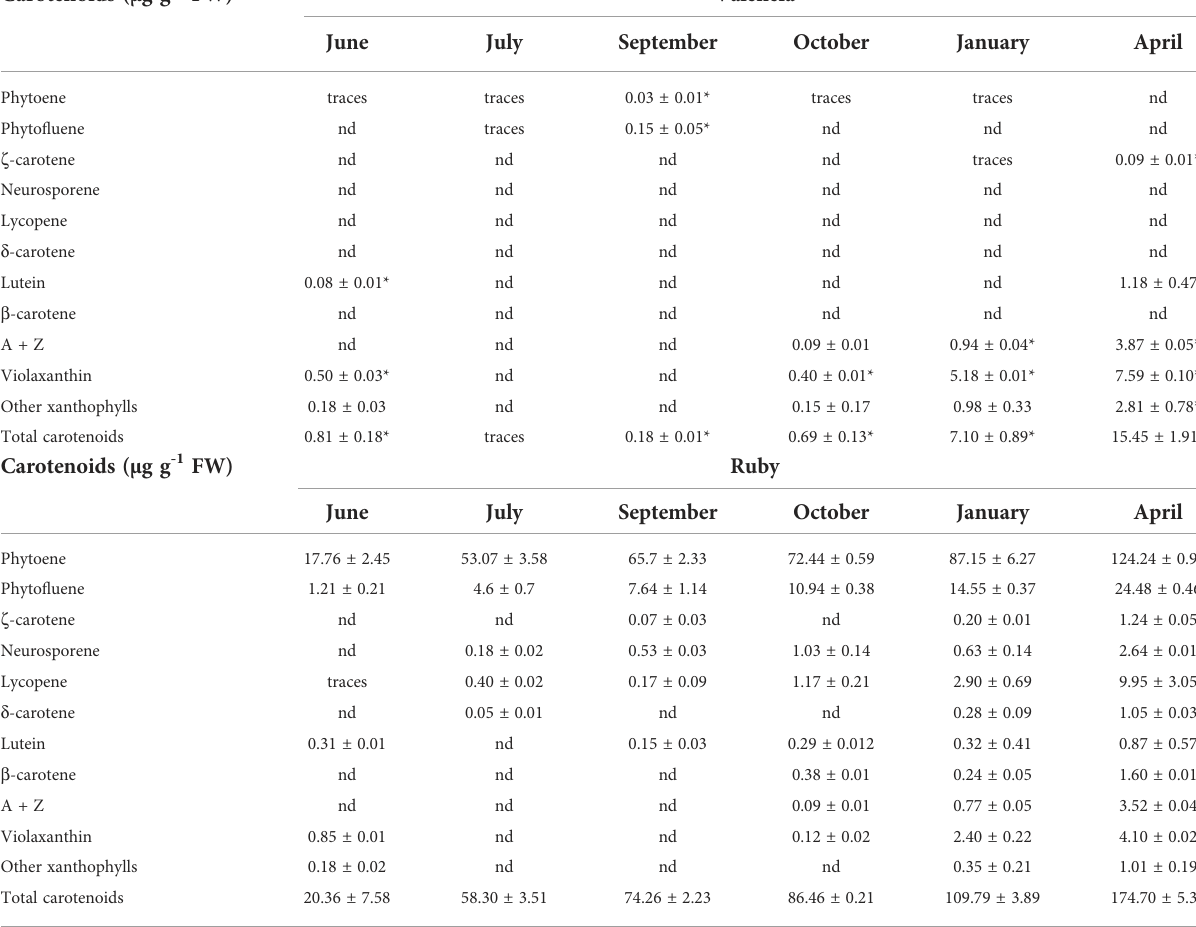
TABLE 2 Carotenoid content and composition (µg g -1 FW) in the pulp of Valencia and Ruby at six different stages of fruit development and maturation. Carotenoids (µg g -1